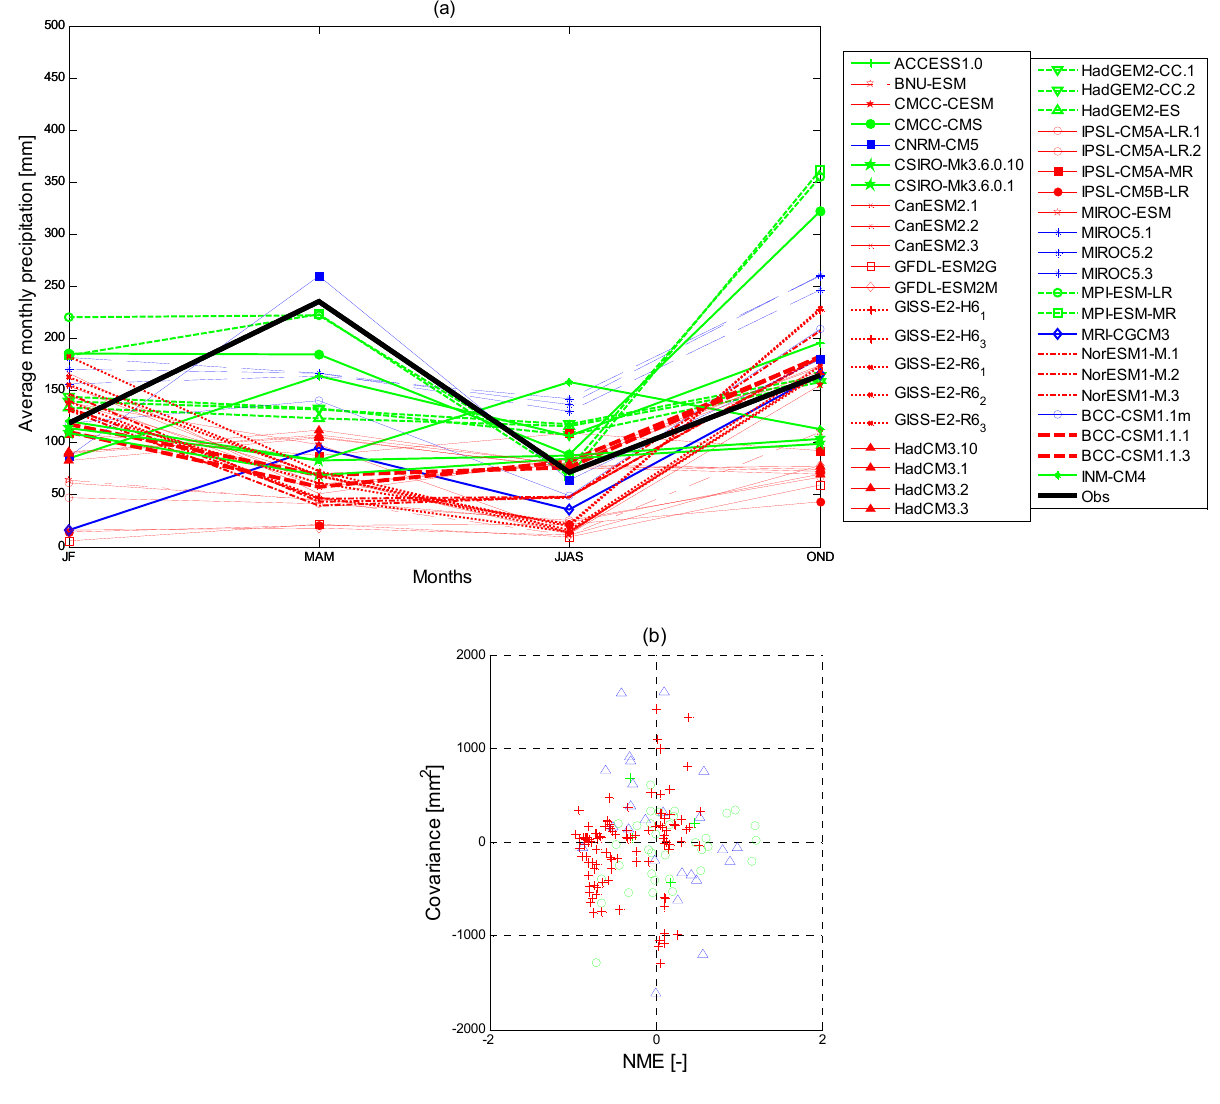
Figure 5. ( a ) Average seasonal precipitation for the different GCMs compared to the observed series for January-February (JF), March-May (MAM), June-September (JJAS) and October-December (OND) aggregations; ( b ) Covariance vs . normalized mean error (NME) for seasonal averages, red: LR GCMs; blue: HR GCMs; green: MR GCMs.